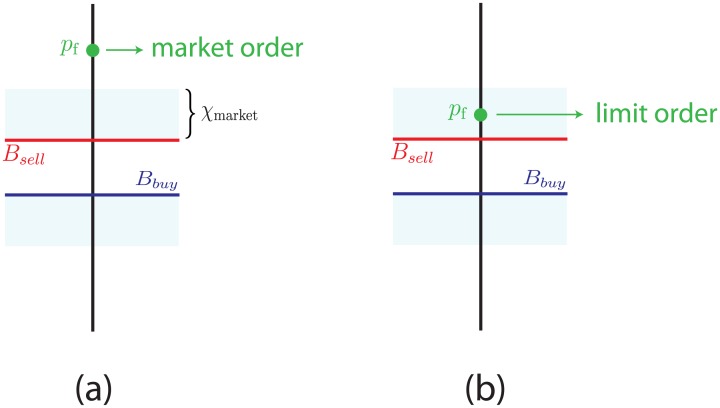
Order selection algorithm for fundamental agents.In (a) we show the conditions that lead to a fundamental agent to introduce a market order: if the fundamental price pf is higher by more than a threshold χmarket (specific to each trader) with respect to the price of the nearest best order, the agent will proceed to enter a market order. Otherwise, the agent will proceed to enter a limit order (b). In the figure the orders would be “buy” orders as the agent’s fundamental price lies above the best ask.